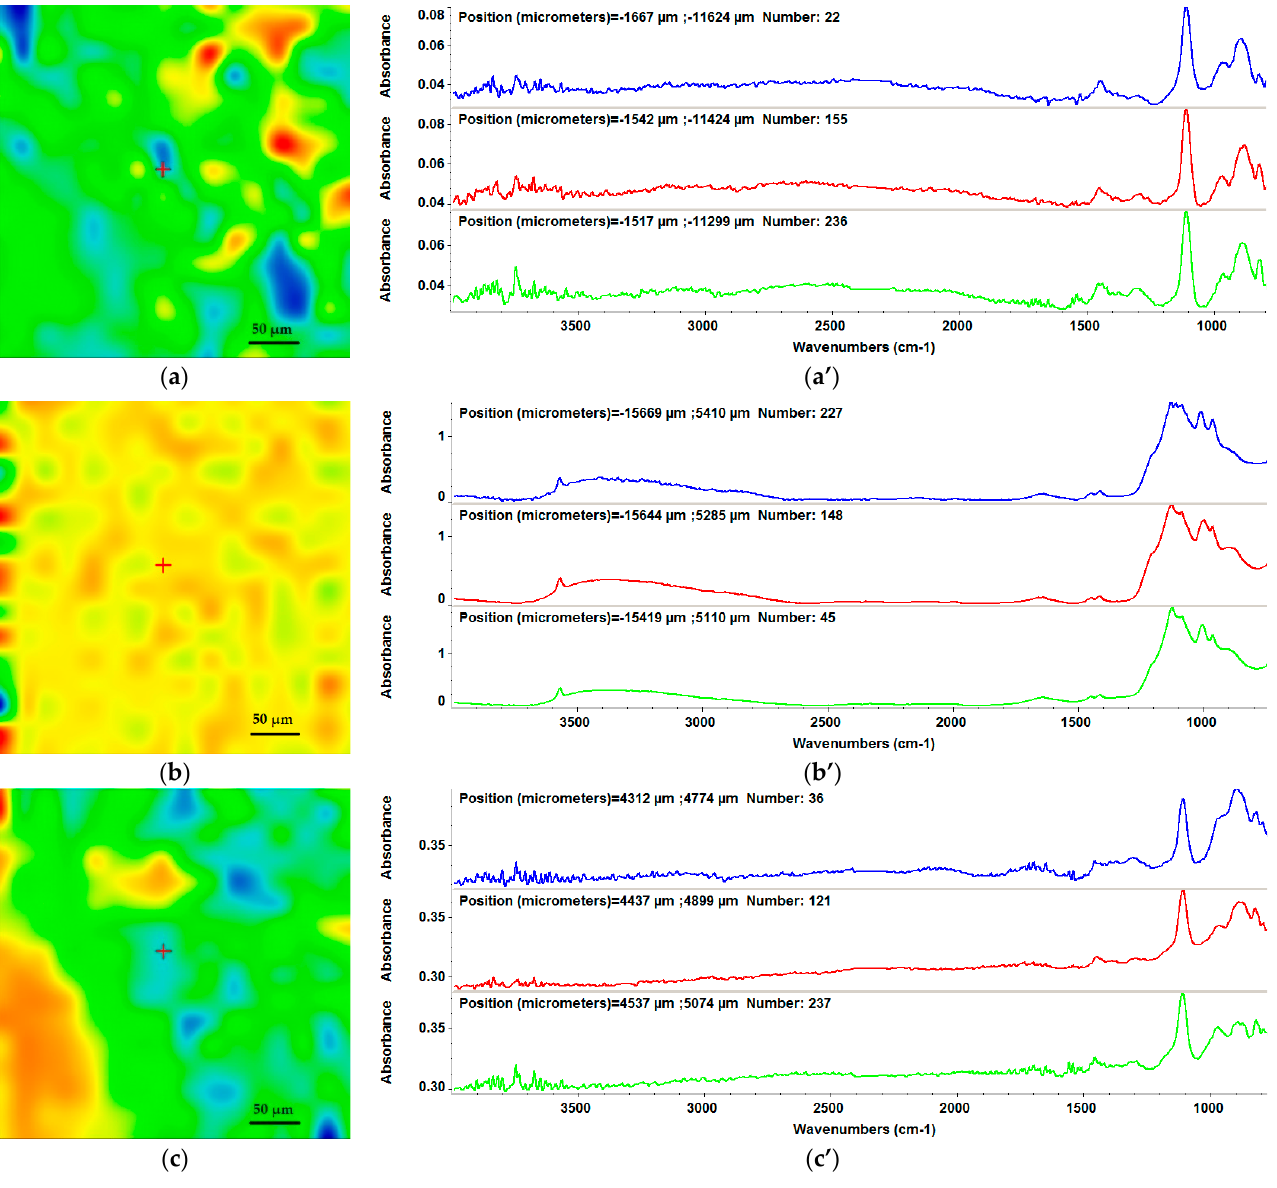
Figure 4. IR maps ( a – c ) and corresponding FT-IR spectra ( a’ – c’ ) for HA/MgP/BMP4 coatings obtained at ( a ) 300 mJ/cm 2 , ( b ) 400 mJ/cm 2 , and ( c ) 500 mJ/cm 2 .